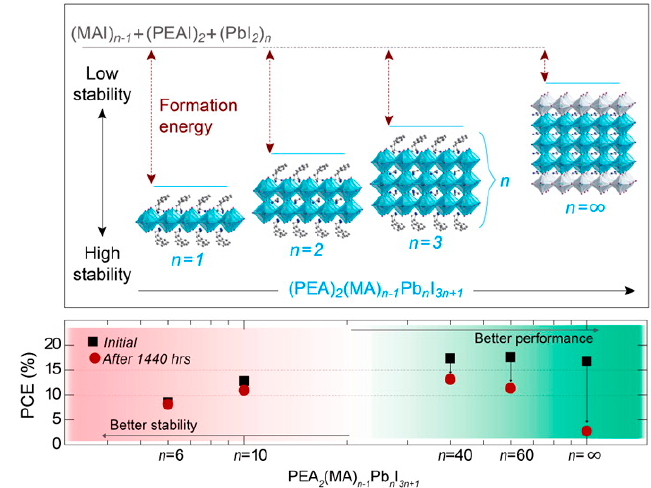
Figure 7. Reducing the dimensionality of organometal halide perovskites leads to higher stability, but lower device performance. Reproduced from ref. [22], with permission from American Chemical Society, 2016